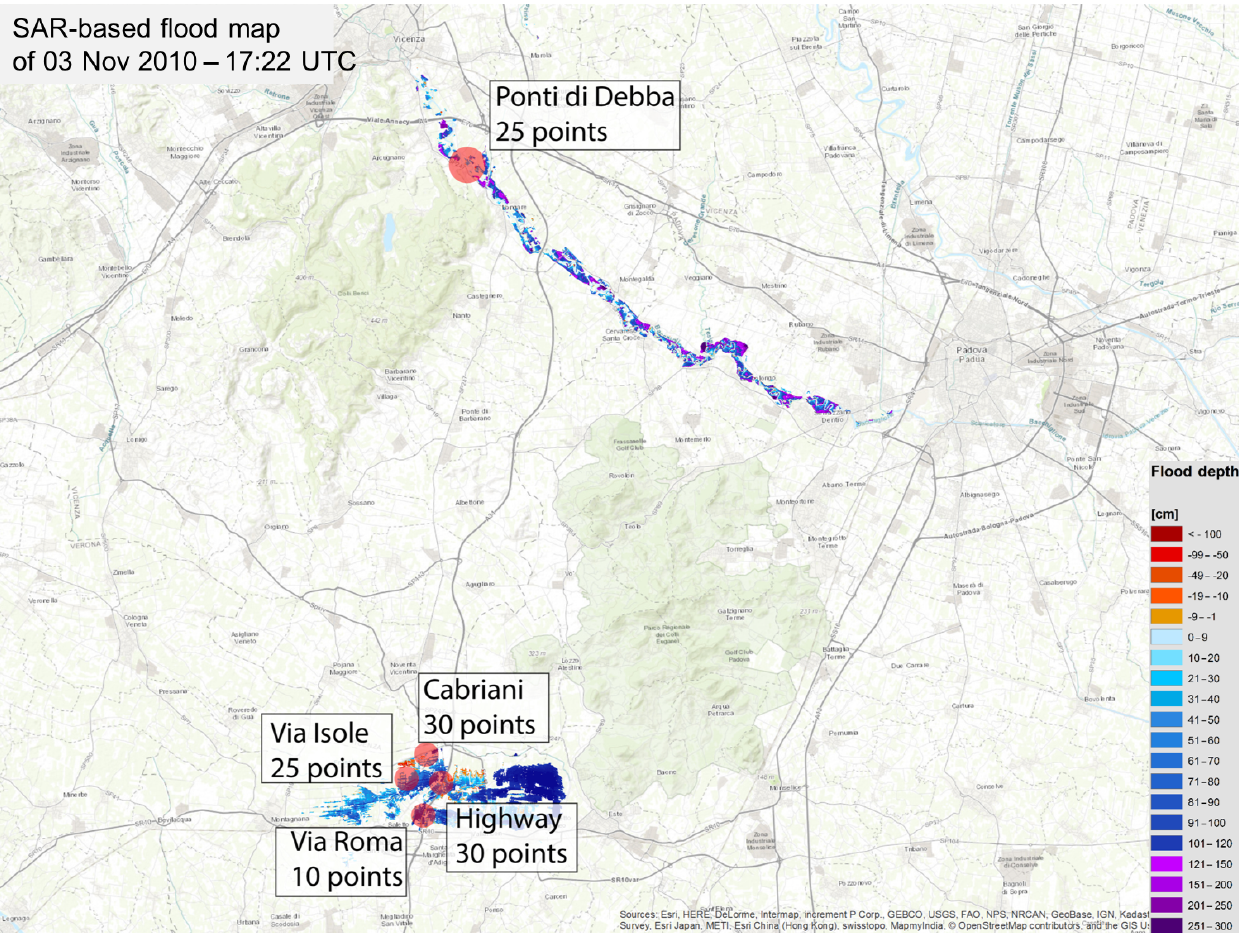
Figure 12. Distribution of the validation points selected for flood depth assessment: a total of 120 validation points collected in the Vicenza and Saletto areas (i.e., 25 and 95, respectively) have been selected based on recognizable features in the aerial and fieldwork photos available for 1 and 2 November. The reported SAR-based flood depth map used for the assessment refers to 3 November